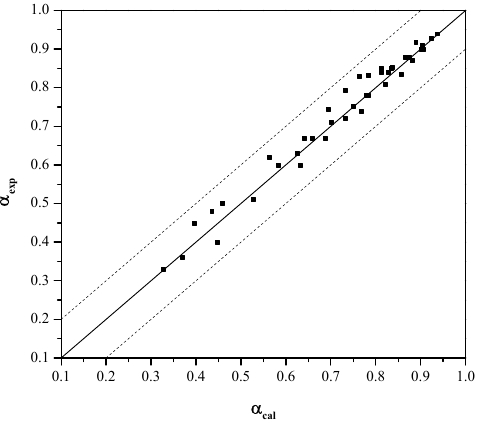
Figure 7 . Comparison of experimental and calculated values of the vanadium leaching efficiency Figure 7. Comparison of experimental and calculated values of the vanadium leaching e ffi